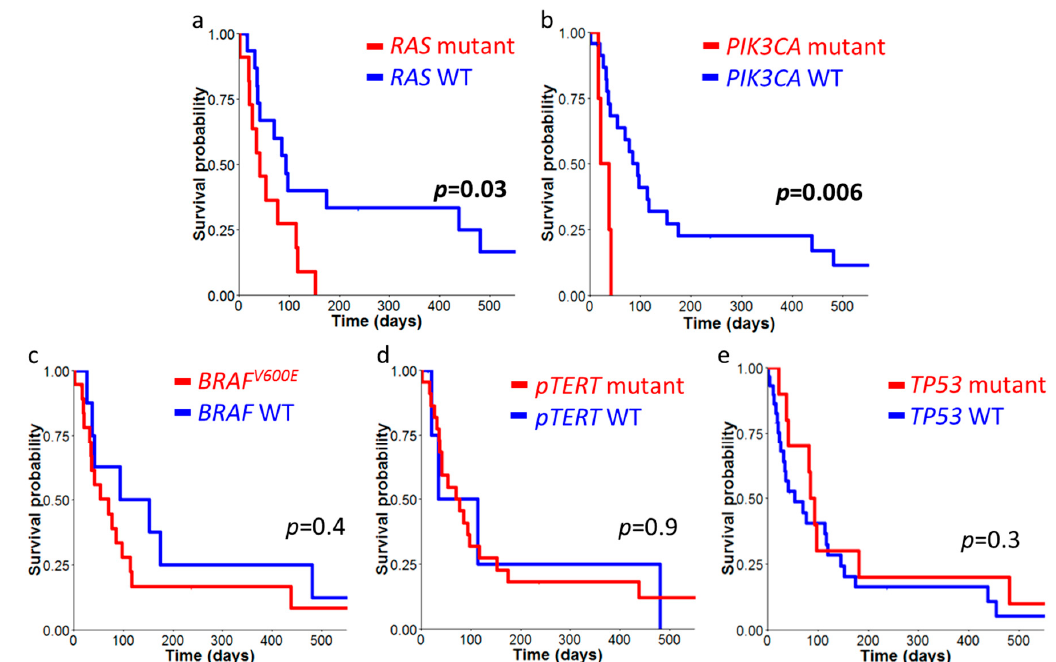
Figure 3. Survival analysis of anaplastic thyroid carcinoma (ATC) . Kaplan–Meier survival analysis was performed with cases stratified by RAS mutations ( a ), PIK3CA exon 2 and exon 9 mutations ( b ), BRAF V600E mutation ( c ), TERT promoter mutation ( d ), and TP53 non-synonymous mutations ( e ). Survival differences were analyzed by log-rank test with significance at p value < 0.05 (bold type). WT, wild-type; pTERT , TERT